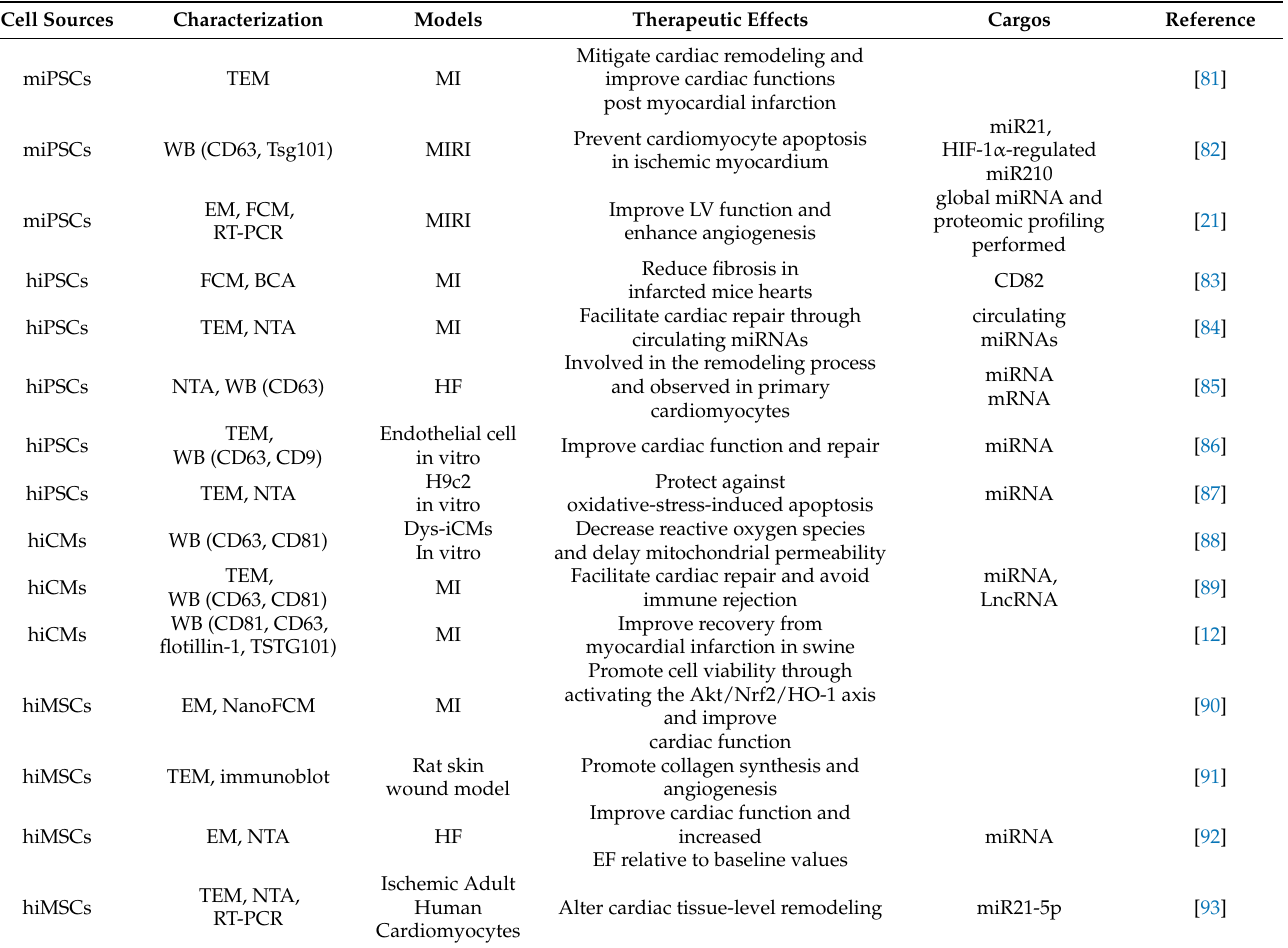
Table 1. The drug delivery of iPSC-sEVs in various disease